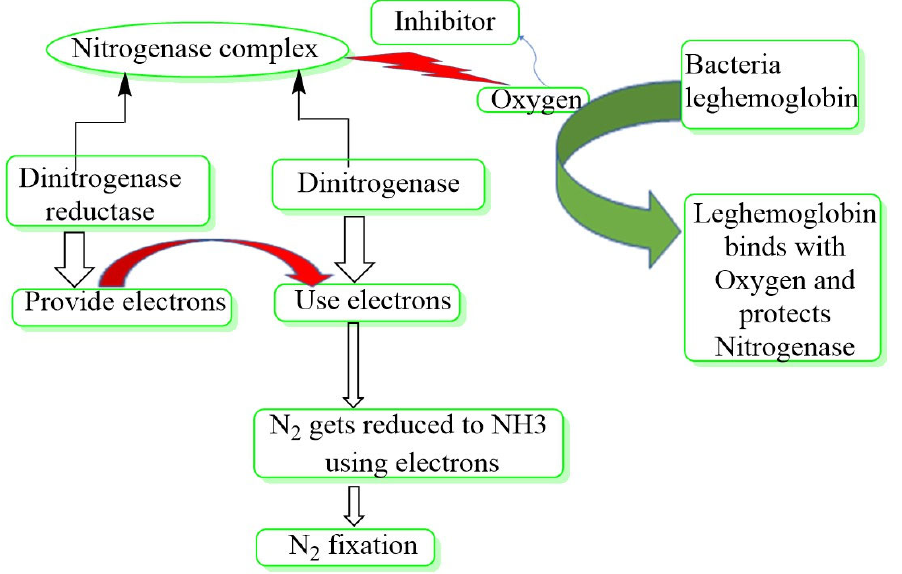
Figure 2. Plant growth-promoting rhizobacteria’s molecular N 2 fixing mechanism. The nitrogen fixation process is carried out by the nitrogenase enzyme complex, which comprises dinitrogenase reductase and dinitrogenase. Dinitrogenase reductase produces electrons, which dinitrogenase uses to convert N 2 to NH 3 . Because the enzyme complex can attach to O 2 and become inactive, oxygen is a powerful inhibitor. Bacterial leghemoglobin, on the other hand, has a higher affinity for oxygen and hence binds to free oxygen more effectively. As a result, the presence of leghemoglobin protects the nitrogenase enzyme complex from oxygen, keeping it active [16].